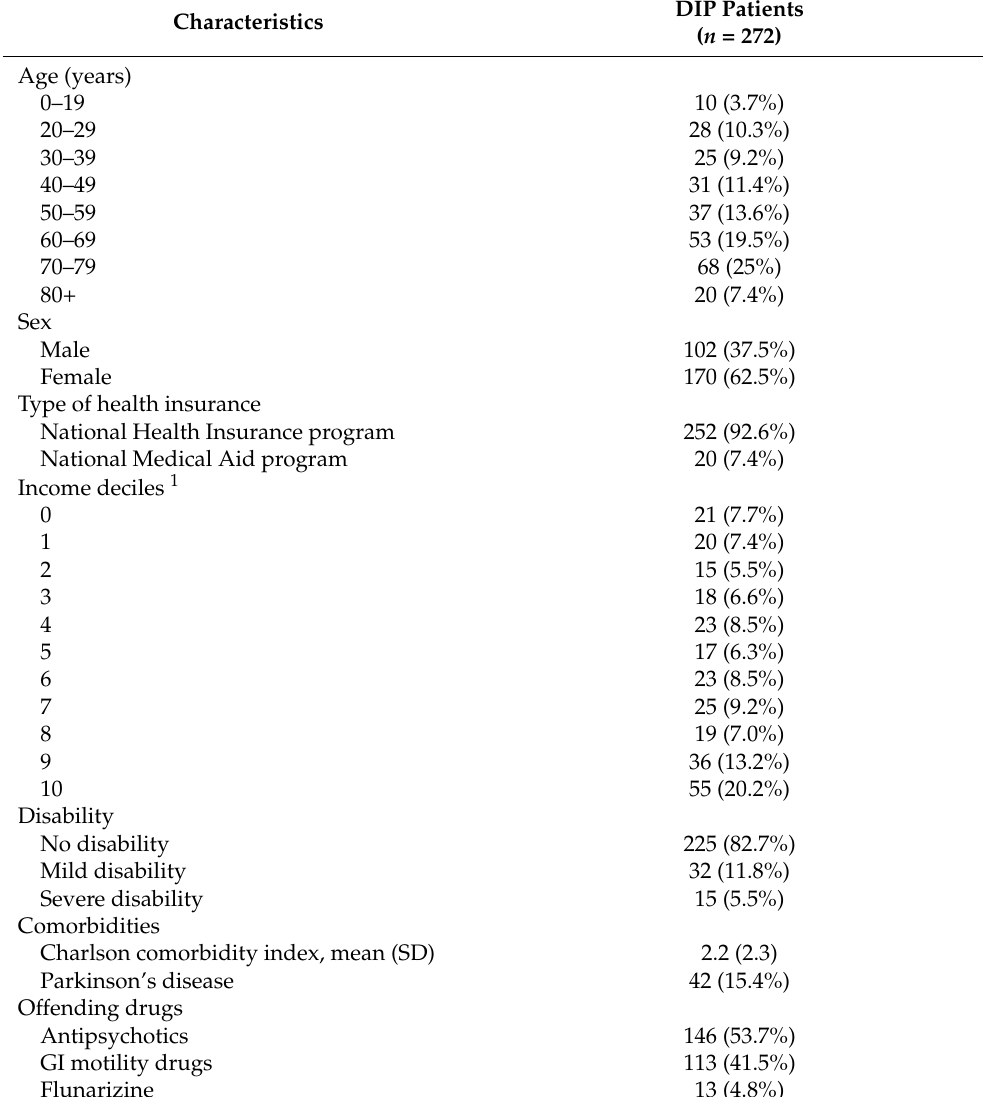
Table 2. Baseline characteristics of patients with drug-induced